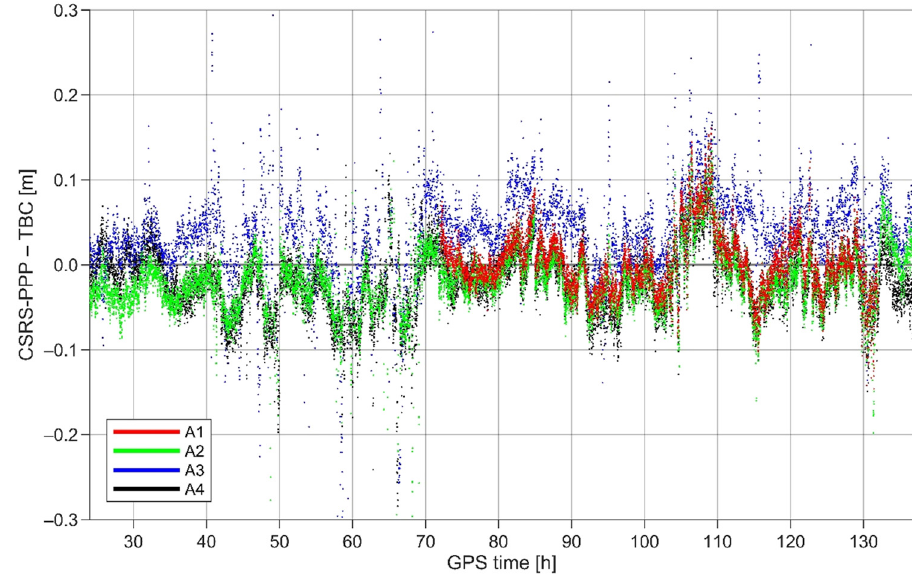
Figure 6: Di ff erences between the CSRS - PPP and TBC SSH solutions for the whole C2 campaign.